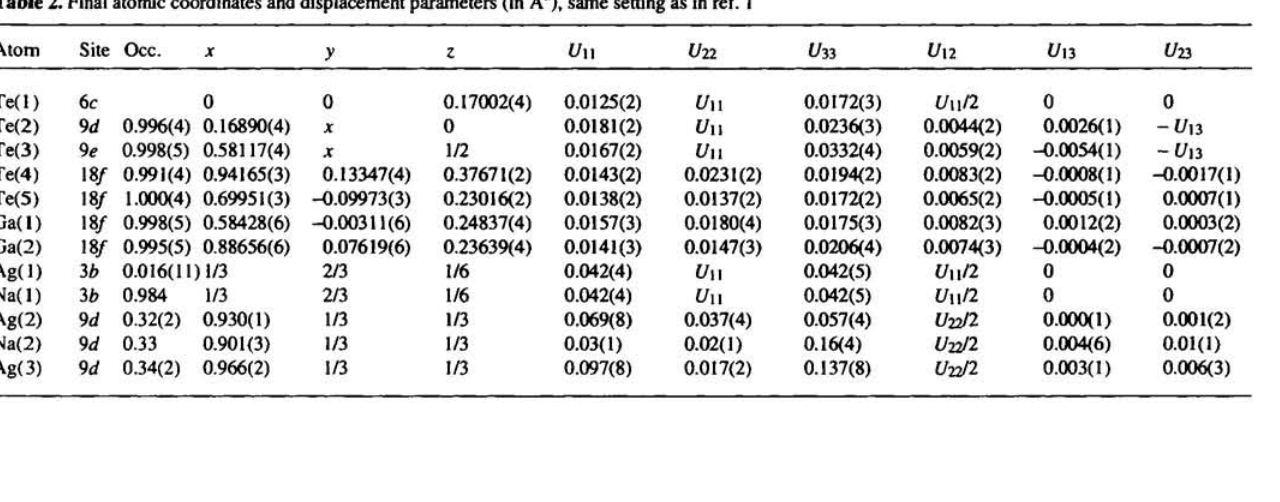
Source of material: Single crystals of NaAgGa^Teio could be prepared from stoichiometric mixtures of the elements at 980 K. NaAgGaôTeio is an intermediate between NaGasTes (see ref. 1)